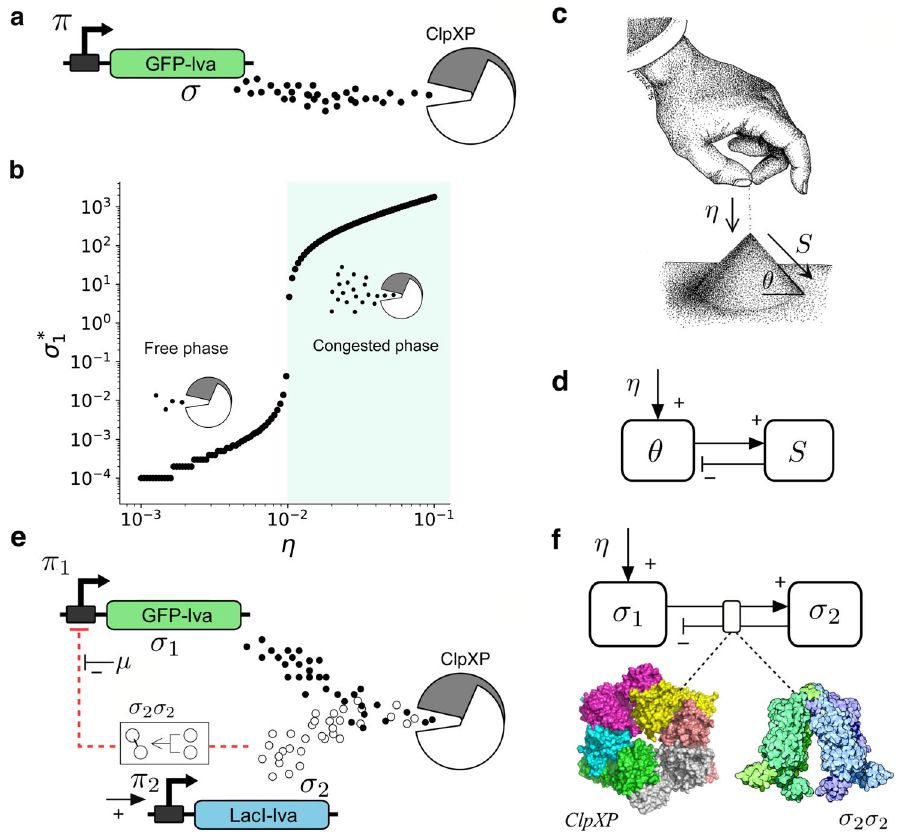
Fig. 1 Paths to intracellular criticality. Tunable critical dynamics can be found in simple genetic circuits ( a ) where a given gene (here coding for GFP-Iva) is constitutively expressed into a protein σ that decays and is also actively degraded by the cell proteolytic machinery (ClpXP). By tuning expression rate η ( d ), a critical rate η c is found to separate a phase of ef fi cient degradation from another involving congestion. In ( b ) the thick line indicates that few proteins are found for η < η c (the proteolytic machinery ef fi ciently degrades it) while it accumulates on the right side, due to congestion (light green; ClpXP fails to degrade all the incoming proteins). An alternative, non-externally tuned path is self-organised criticality (SOC), provided by the sandpile ( c , adapted from @ ricard_sole Oct. 2017). As grains of sand are slowly added at a rate η , the angle of the pile θ grows and only small avalanches will be observed. However, as the critical (maximum) θ c is reached, avalanches of all sizes take place, reducing θ . The feedback between the order parameter ( S ) and the control parameter ( θ ) is summarised in ( d ). To facilitate the conditions enabling SOC, a two-gene circuit with negative feedback ( e ) allows mapping the sandpile feedback diagram ( f ). Here, both proteins compete for ClpXP (higher levels of σ 1 also implies high values of σ 2 ) and repression feedback is mediated by σ σ σ σ 2 2 (the Lac repressor dimer) with 1 and 2 acting as order and control parameters, respectively. Protein models generated using Pymol